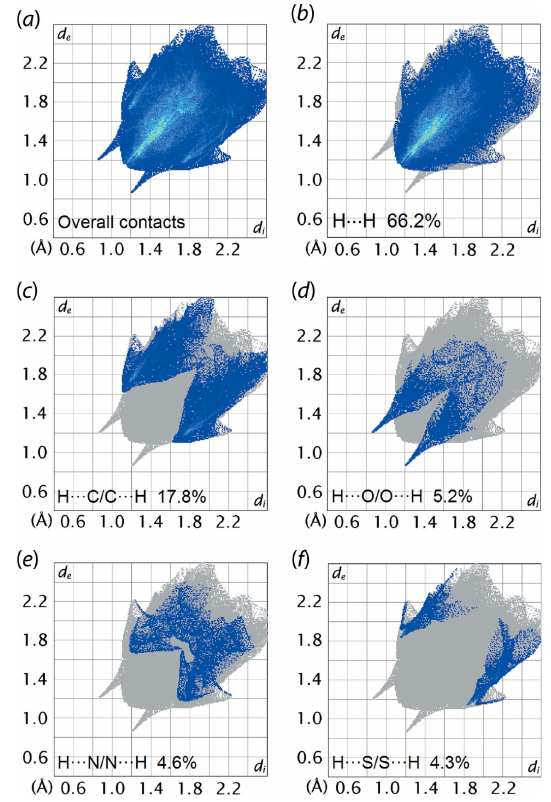
Figure 6 ( a ) A comparison of the full two-dimensional fingerprint plot for (I) and those delineated into ( b ) H (cid:2)(cid:2)(cid:2) H, ( c ) H (cid:2)(cid:2)(cid:2) C/C (cid:2)(cid:2)(cid:2) H, ( d ) H (cid:2)(cid:2)(cid:2) O/O (cid:2)(cid:2)(cid:2) H, ( e ) H (cid:2)(cid:2)(cid:2) N/N (cid:2)(cid:2)(cid:2) H and ( f ) H (cid:2)(cid:2)(cid:2) S/S (cid:2)(cid:2)(cid:2) H contacts. (cid:7) 3.0 A˚ in each of Fig. 6( e ) and ( f ), mirrored features at d + d e i with the minimum distance being around the sum of their respective van der Waals radii. The other interatomic contacts, i.e . C (cid:2) (cid:2) (cid:2) C and C (cid:2) (cid:2) (cid:2) N/N (cid:2) (cid:2) (cid:2) C, have a negligible effect on the molecular packing and their contributions to the overall Hirshfeld surface are 1.7 and 0.2%, respectively.